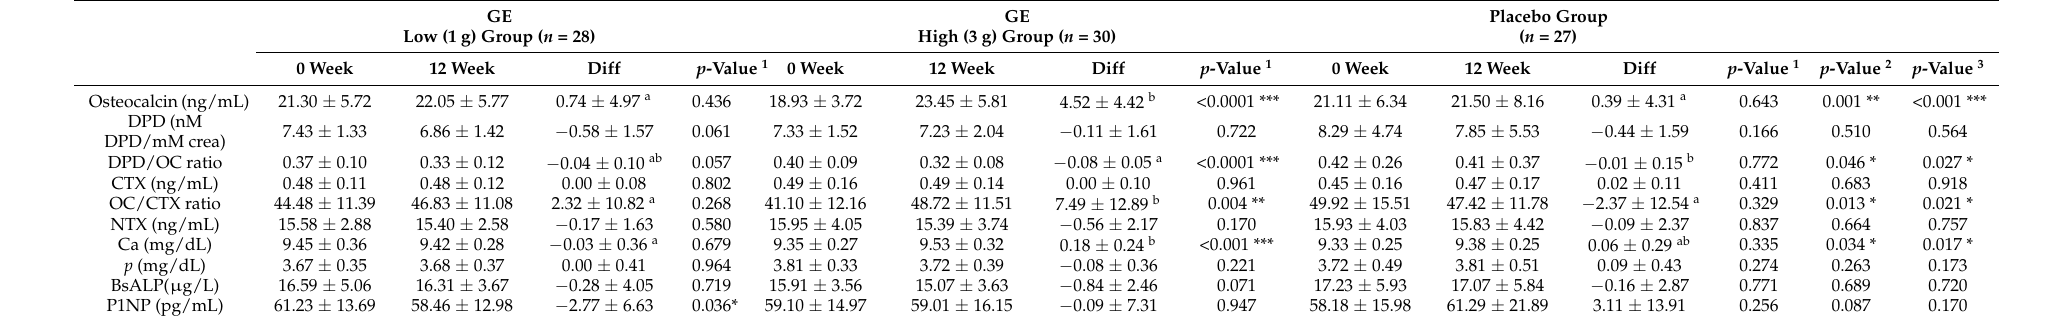
Table 4. Changes in bone turnover markers in subjects during the intervention